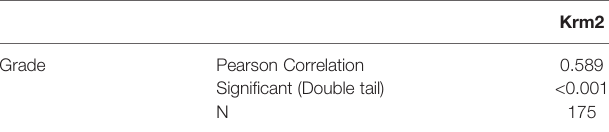
TABLE 3 | Relationship between Kremen2 expression and tumor characteristics in patients with gastric